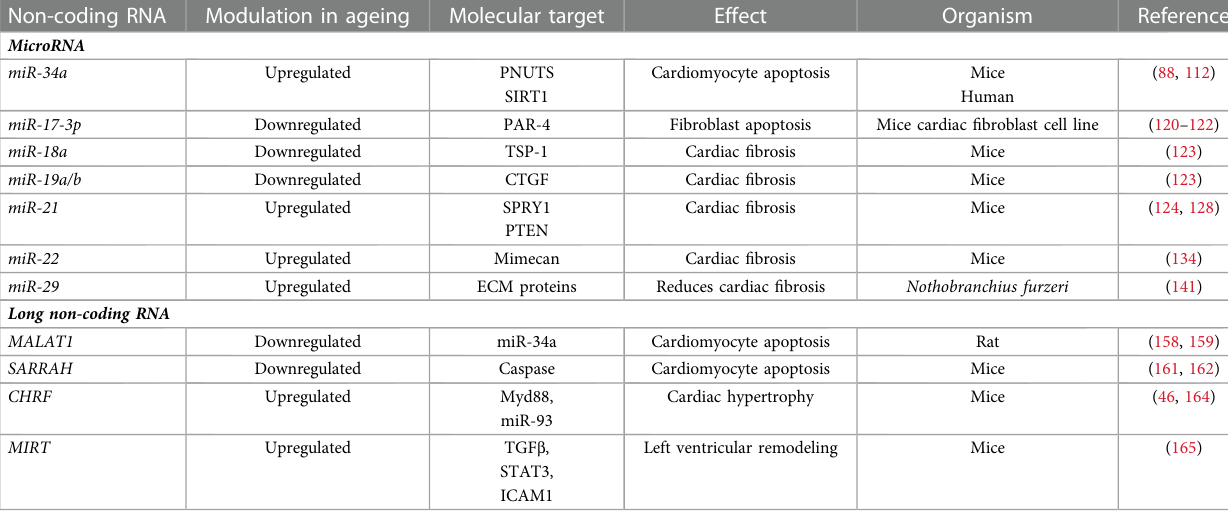
Non-coding RNAs associated with cardiac ageing: PNUTS, Phosphatase-1 nuclear-targeting subunit; SIRT1, Sirtuin 1; PAR-4, Protein prostate apoptosis response-4, TSP-1, Thrombospondin- 1; CTGF, Connectivetissue growth factor; SPRY1, Sproutprotein homolog 1; PTEN, Phosphatase and tensin homolog; ECM proteins, Extracellular matrix proteins (collagen, fi brillin, and elastin), MYD88, Myeloid differentiation protein-88; TGF β , Tissue growth factor β ; STAT3, Signal transducer and activator of transcription 3; ICAM1, Intercellular adhesion molecule